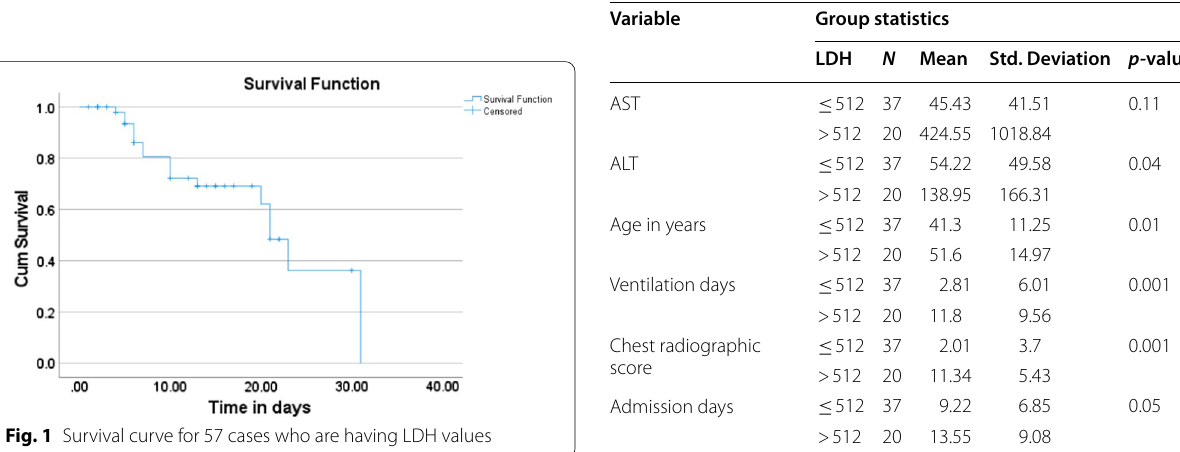
Table 1 Comparison of clinical parameters according to